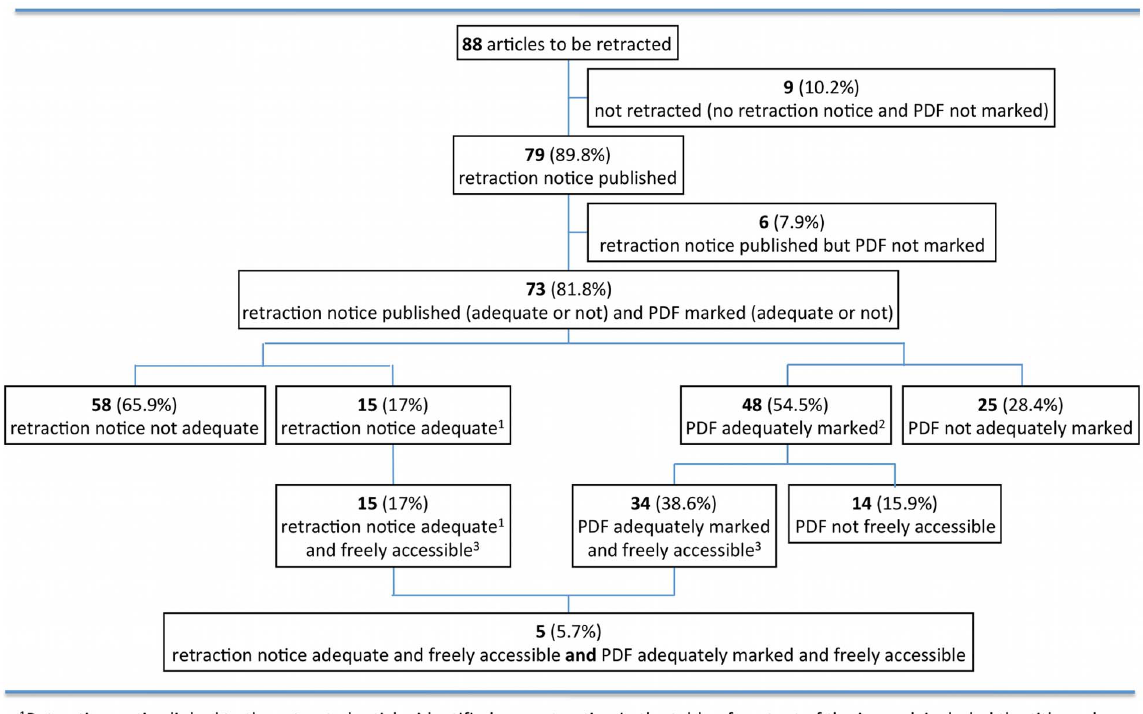
Figure 1. Flow chart. 1 Retraction notice linked to the retracted article, identified as a retraction in the table of content of the journal, included the title and authors of the retracted article in its heading, explained who took the responsibility for retraction, and provided reasons for retraction. 2 Watermark transparent, not opaque, and the original text preserved. 3 Through PubMed or alternative websites.